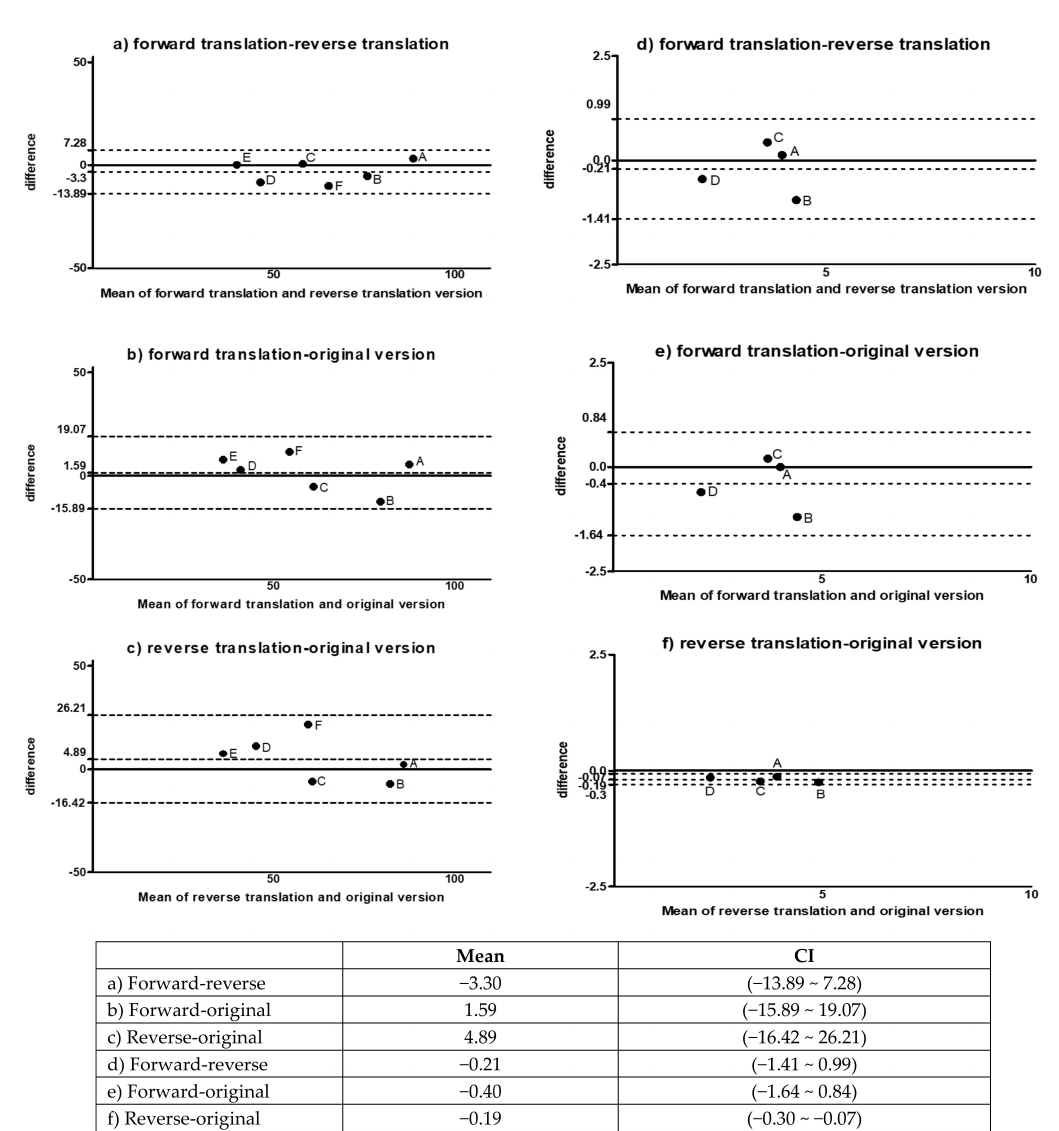
Figure A1. Bland–Altman plots for ASCO and ESMO evaluation. Bland–Altman plot for ( a ) forward translation and reverse translation, ( b ) forward translation and original version, ( c ) reverse translation and original version used for ASCO evaluation. Bland–Altman plot for ( d ) forward translation and reverse translation, ( e ) forward translation and original version, ( f ) reverse translation and original version used for ESMO evaluation. The median dotted lines parallel to the x -axis indicate the mean. The above and below dotted lines indicate the 95% confidence limits. A~F are Clinical Value assessment result of the six drugs including one targeted therapy for non-small cell lung cancer, three cancer immunotherapies, and two treatments for multiple